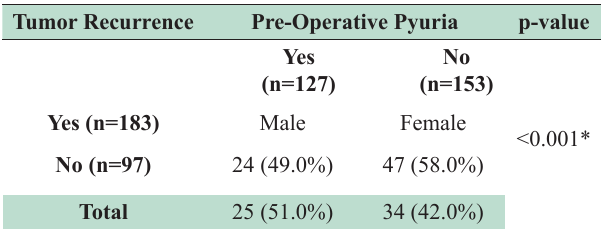
Table-V: Comparison of Tumor Recurrence between Patients with and without Pre-operative Pyuria n=280.